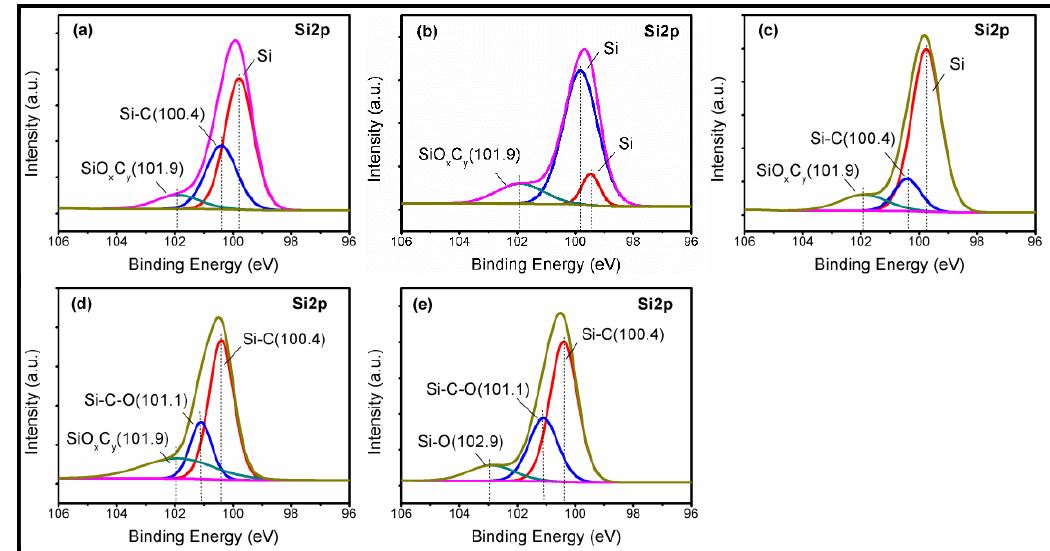
Figure 4. XPS Si2p spectra of Si-face 6H-SiC surfaces using CMP slurry: ( a ) before chemical corroding; ( b , c ) conventional chemical corroding (C-c’, U-c’); ( d , e ) ultrasonic chemical corroding (C-u’,